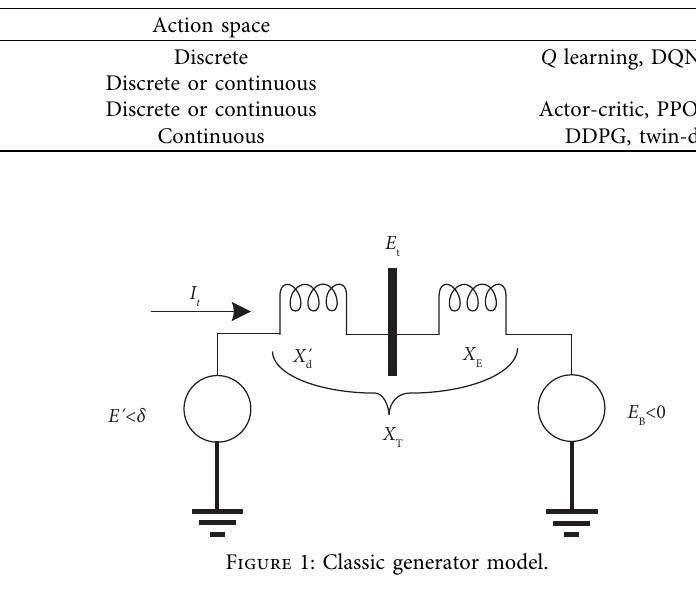
Figure 1: Classic generator model.